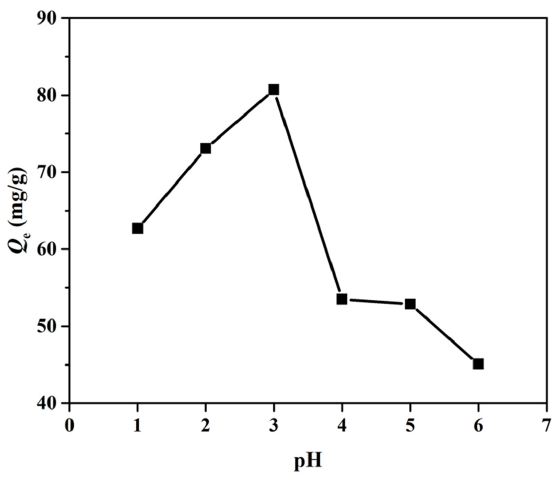
Figure 4. Effect of different acid concentration on adsorption capacity.